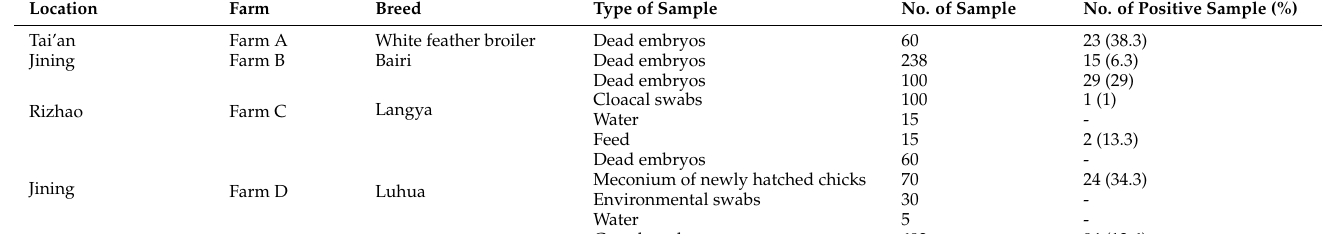
Table 1. Number of samples and prevalence of Salmonella in Poultry farms ( n = 693).